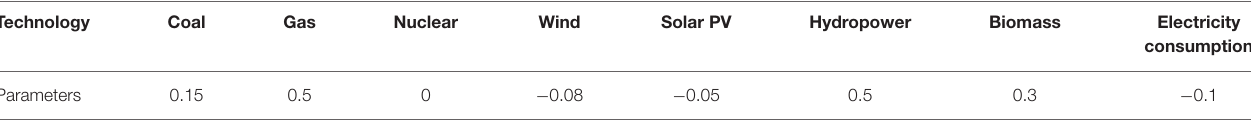
TABLE 3 | Flexibility factors.